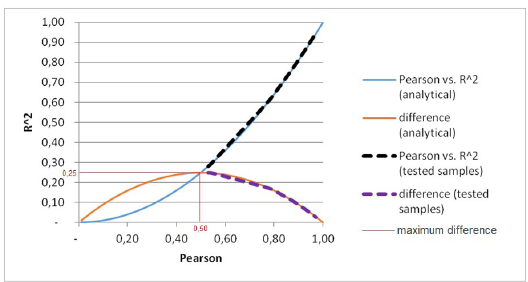
Figure 14. Analytical values (continuous line) and tested samples’ values (dashed line) of Pearson versus R 2 and the difference between them; maximum difference (red